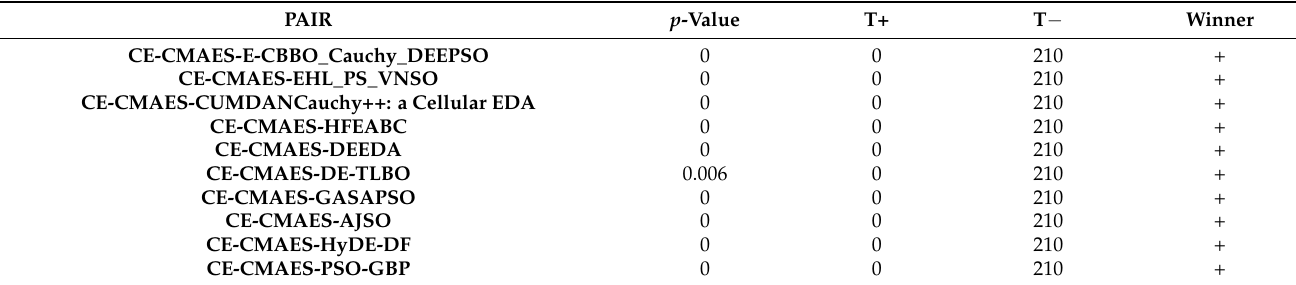
Table 5. Wilcoxon Signed Ranks Test